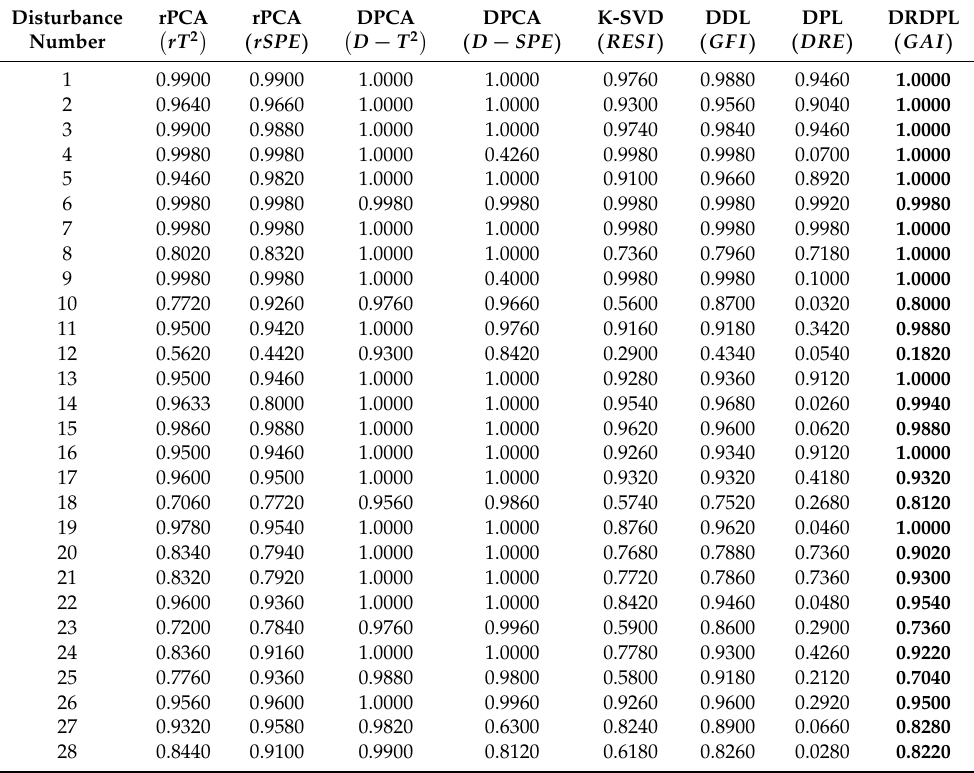
schematic diagram of TE process monitoring based on DRDPL, refer to Figure 2. Table 3 shows that the FDRs of all methods in TE processes with various disturbances. The results of process monitoring show that the proposed method has high FDR for most disturbances. Table 3. The FDR of the proposed method and comparative methods for 28 kinds of disturbances in TE